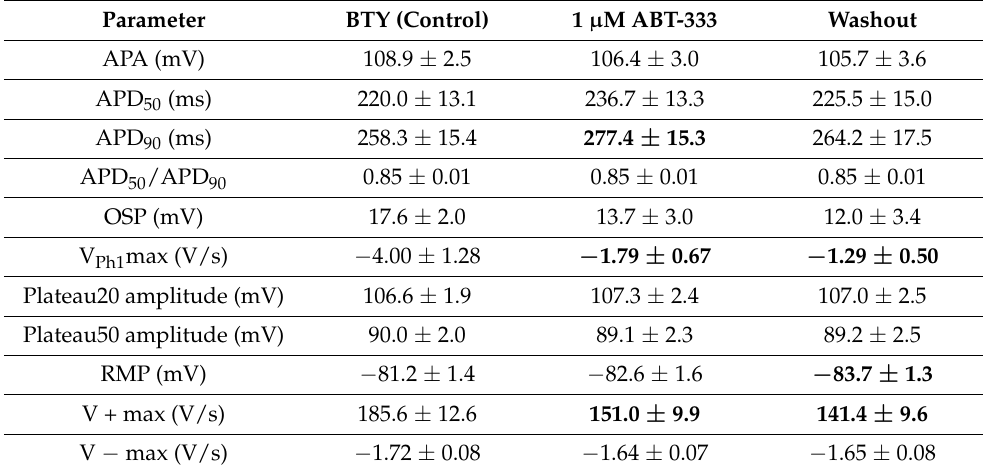
Table 1. AP parameters obtained with 1 µ M ABT-333.